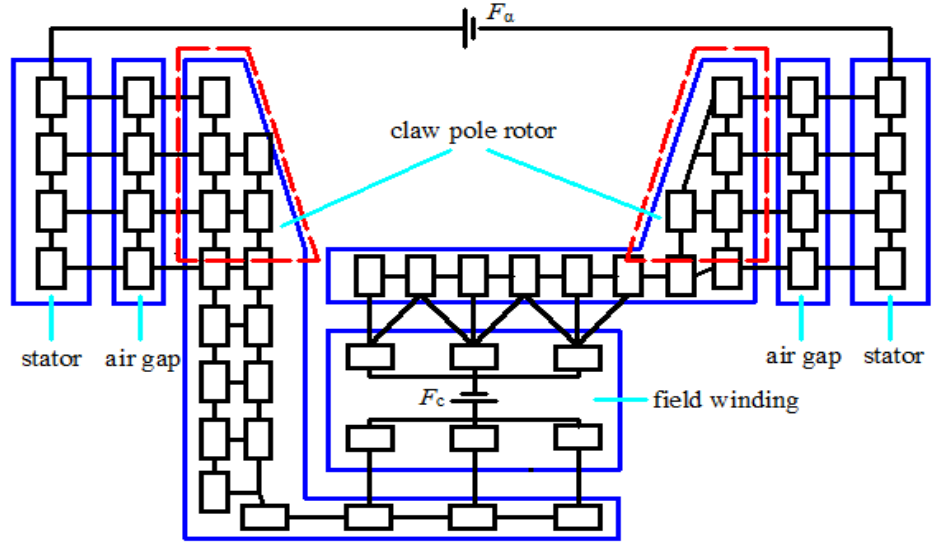
Figure 2. Equivalent magnetic network model.